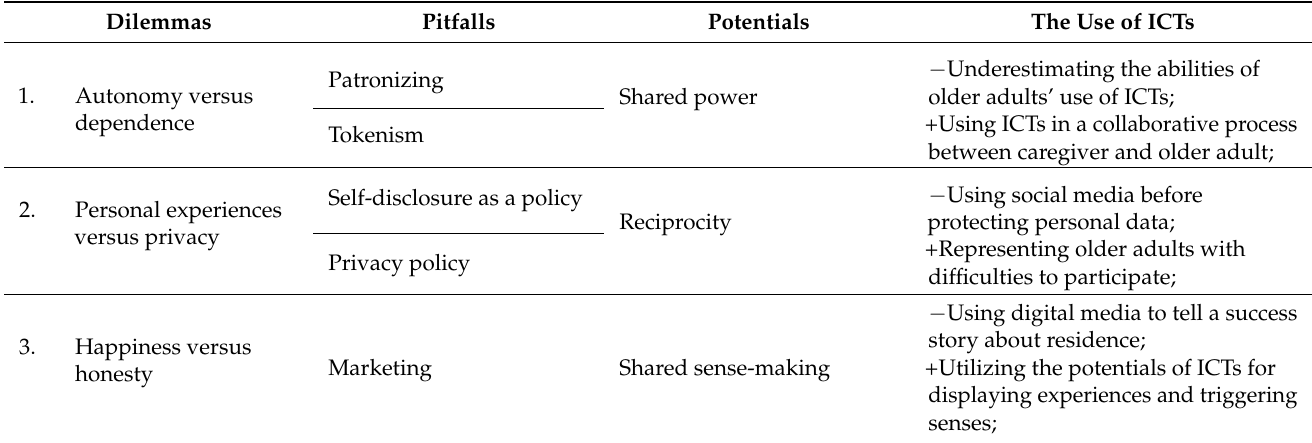
Table 2. Dilemmas, pitfalls, and